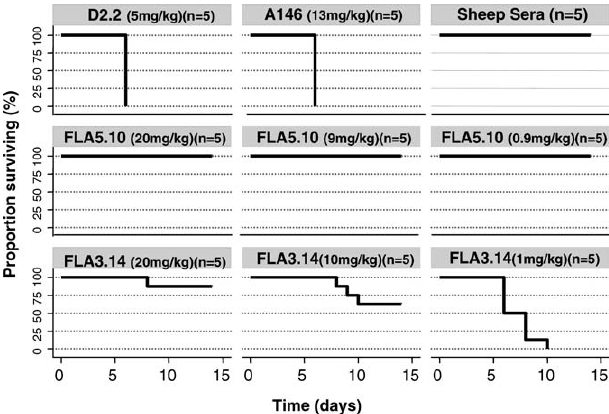
Figure 1. Passive Immunization and Survival after Challenge with A/ Vietnam/1203/04 (H5N1) BALB/c mice ( n ¼ 5 per group) were passively immunized by i.p. injection of graded doses of anti-H5N1 mAbs FLA3.14 or FLA5.10, the control mAbs D2.2 or A146, or hyperimmune sheep antisera specific for the H5N1 HA protein. Mice were challenged i.n. with 50 l l of A/Vietnam/ 1203/04 (10 5 TCID 50 /mouse) 24 h later. The data show the Kaplan-Meier survival curves for the 2 wk period of observation. Mice that received either sheep anti-H5 antisera or FLA5.10 were completely protected from lethal infection (sheep antisera or FLA5.10 versus D2.2, p ¼ 0.001, log rank test). FLA3.14 afforded significant protection at 20 mg/kg and 10 mg/kg (FLA3.14 versus D2.2, p ¼ 0.001, log rank test). The lowest dose of FLA3.14 (1 mg/kg) delayed time to death (FLA3.14 versus D2.2, p ¼ 0.02, log rank test), but did not prevent fatal infection.